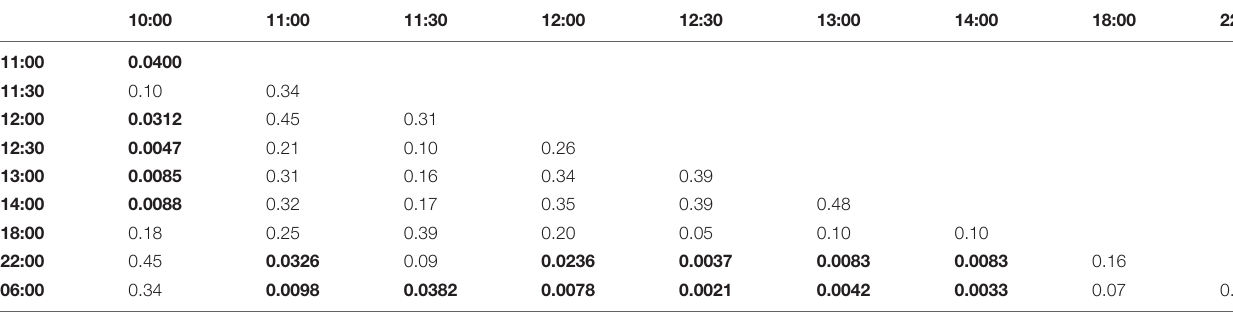
p-values less than 0.05 shown in bold. TABLE 3 | Adjusted p -values for Artificial Rain Experiment (16:00-18:00